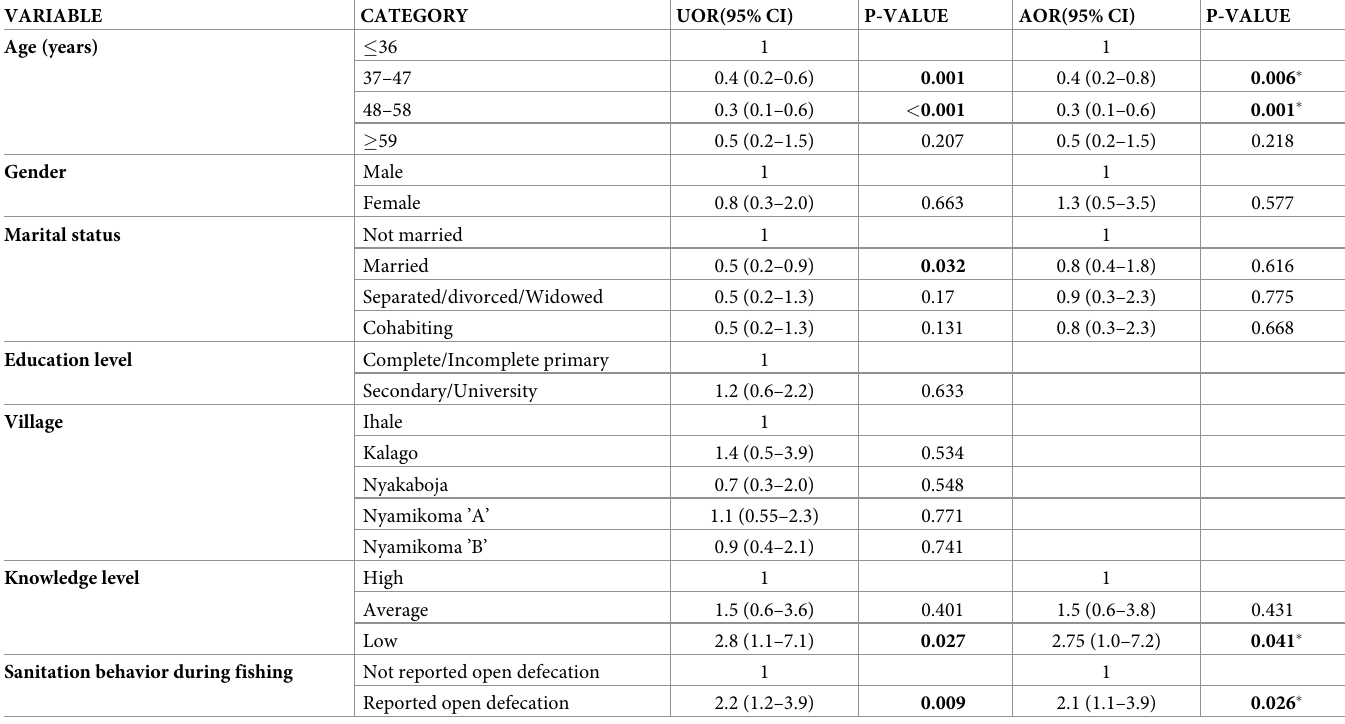
Table 4. Logistic regression analysis of infection status and risk